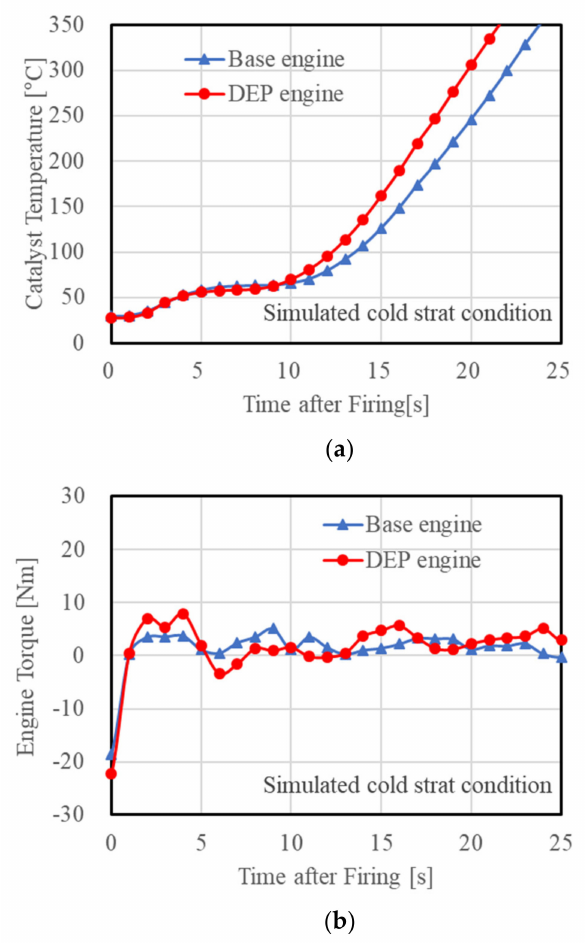
Figure 17. Light-off time reduction: ( a ) Comparison of light-off time: ( b ) engine torque under simulated cold-start catalyst-heating